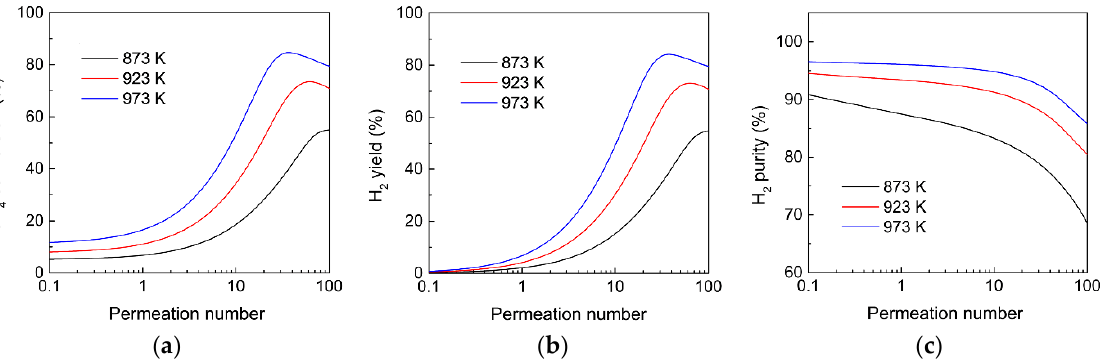
Figure 6. Effect of the reaction temperature on ( a ) CH 4 conversion, ( b ) H 2 yield, and ( c ) H 2 purity as a function of the permeation number for MDA in the membrane reactor. (Simulation conditions: Da = 5, α H = 200, α CH = Knudsen selectivity, p h = 1 bar, p l = 0.05 2 / CH 4 4 / C 6 H 6